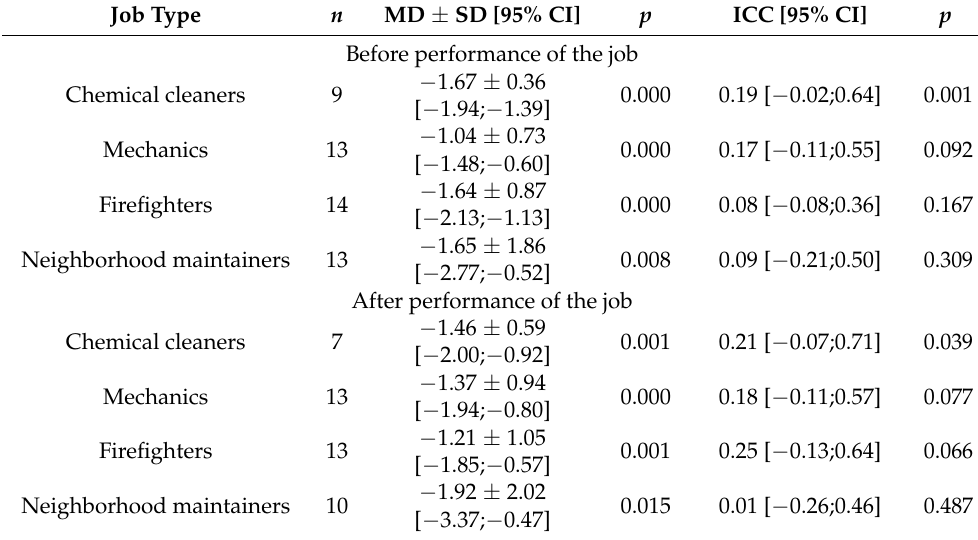
Table A2. Cosinuss ◦ raw per subject. The (raw) Cosinuss ◦ was compared with the ear canal IR thermometer per company using the intraclass correlation coefficient (ICC) with a confidence interval of 95% and p